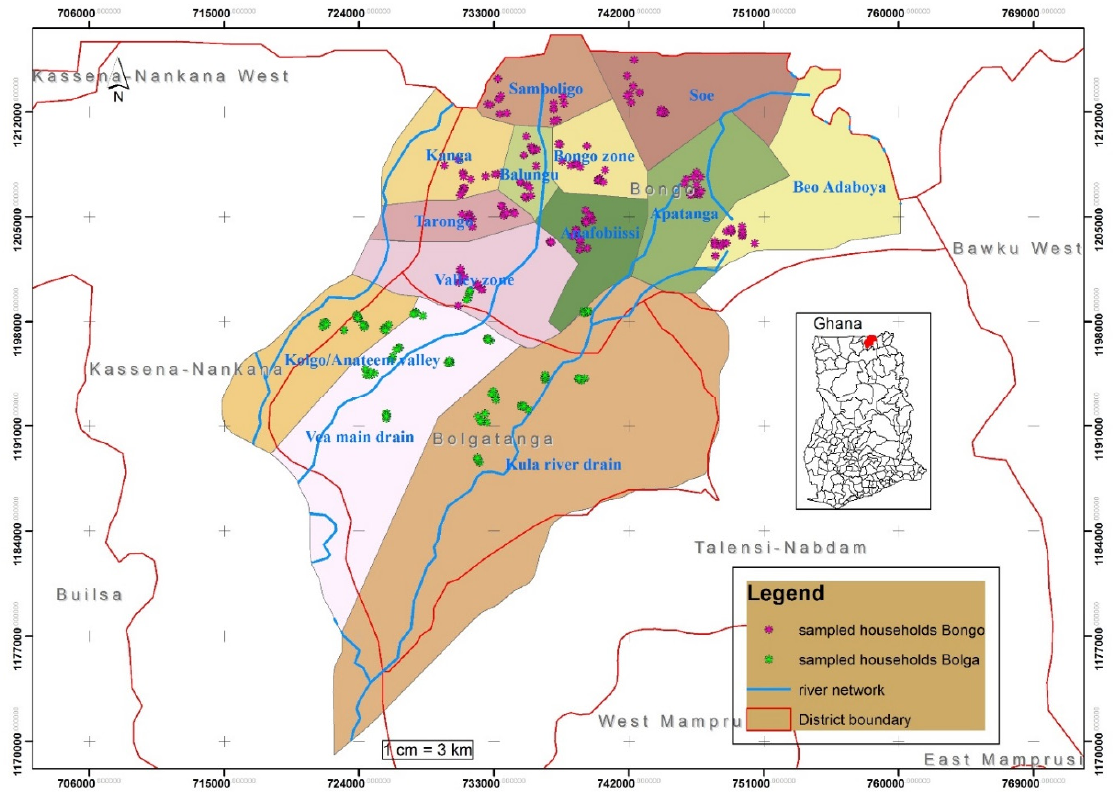
Figure 1. The Vea study area of